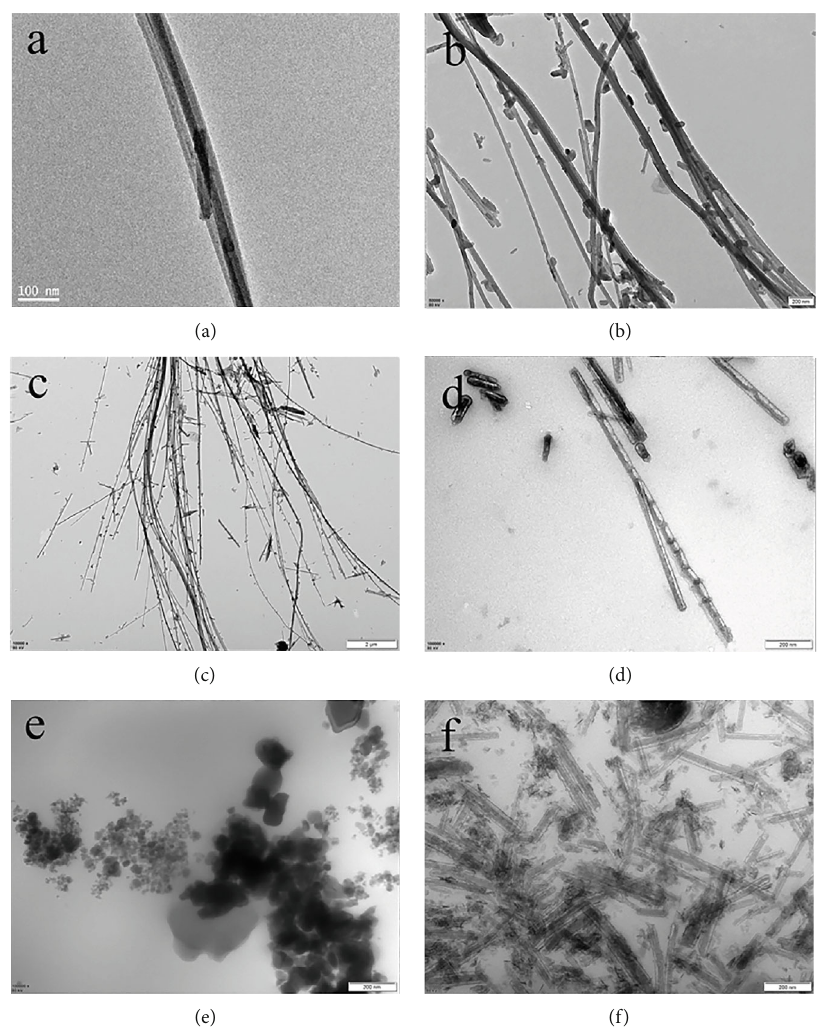
Figure 4: TEM of samples: (a) Sep, (b, c) Sep@Fe